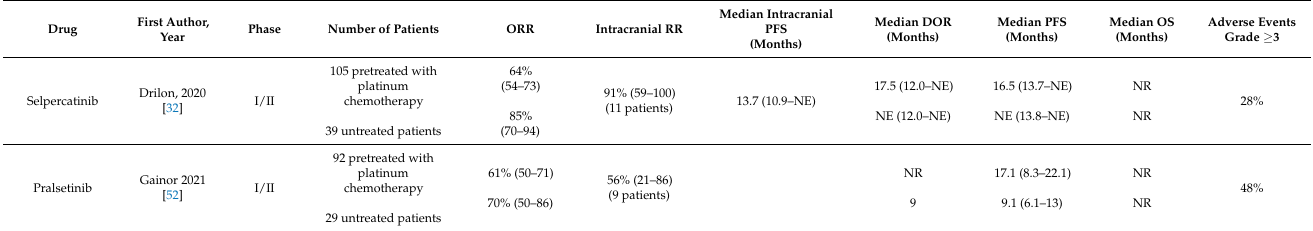
Table 2. Prospective clinical trials of selective RET inhibitors in RET-rearranged non-small cell lung